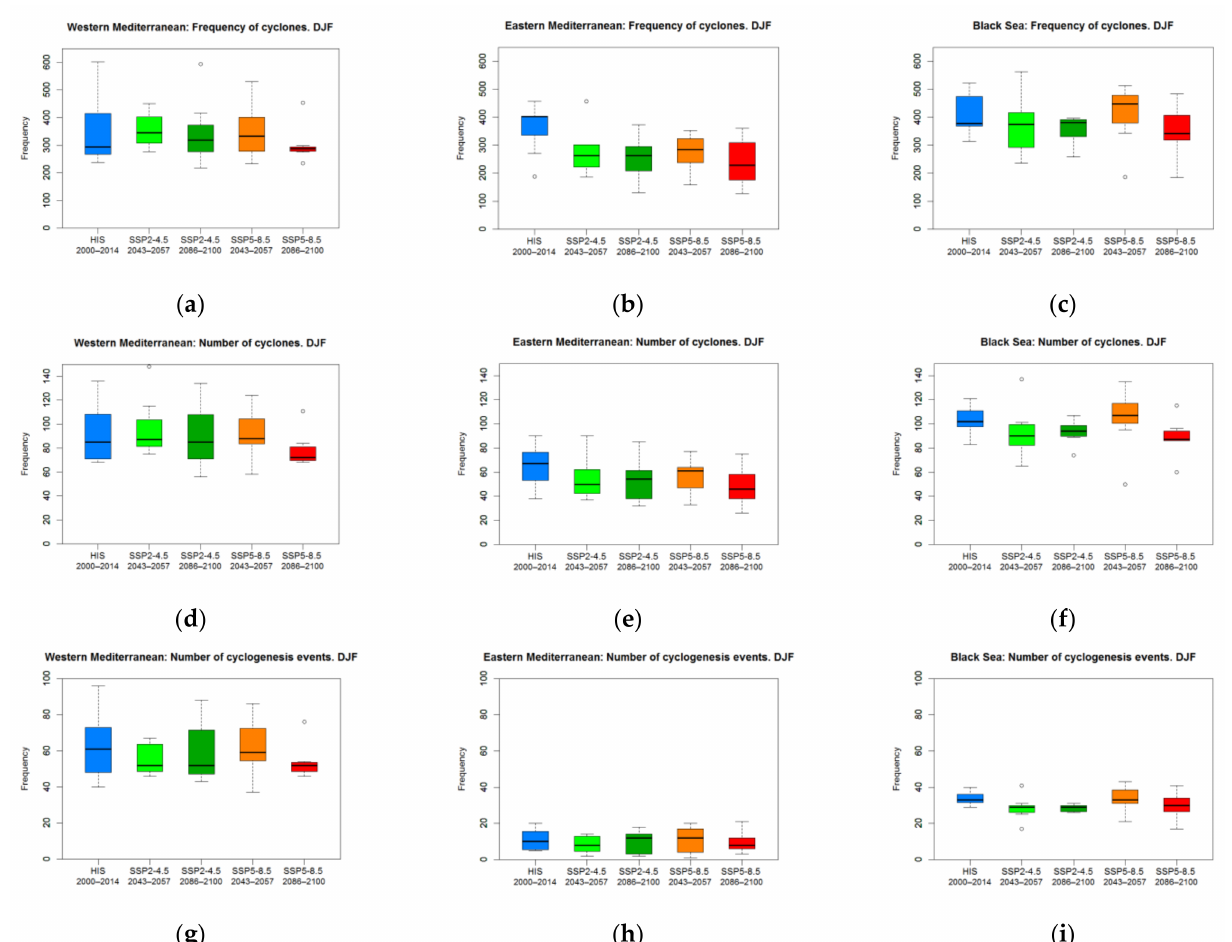
Figure 7. Boxplots of the area-averaged winter cyclone numbers (total for 15 seasons): ( a – c ) frequency of cyclones; ( d – f ) number of cyclones; ( g – i ) number of cyclogenesis events. Cyclone numbers are averaged over the following subregions (see Figure 1): ( a , d , g ) western Mediterranean; ( b , e , h ) eastern Mediterranean; ( c , f , i ) Black Sea. The averaging periods are the recent historical period (blue), middle of the century under the SSP2-4.5 scenario (light green), end of the century under the SSP2-4.5 scenario (green), middle of the century under the SSP5-8.5 scenario (orange), and end of the century under the SSP5-8.5 scenario (red). The black line in the boxes is the median, the boxes’ range is from the 25th percentile to the 75th percentile, the whiskers’ range is from the 5th percentile to the 95th percentile, and the white dots mark the